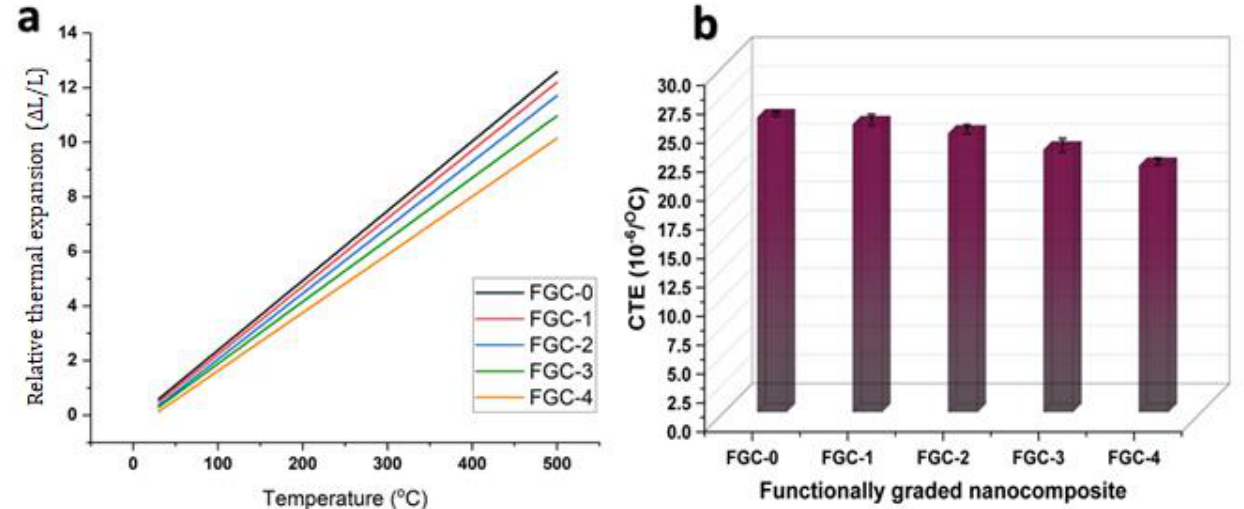
Figure 10. ( a ) Relative thermal expansion of FGC layers studied at 30 − 500 °C and ( b ) Variations in CTE value for different FGCs.